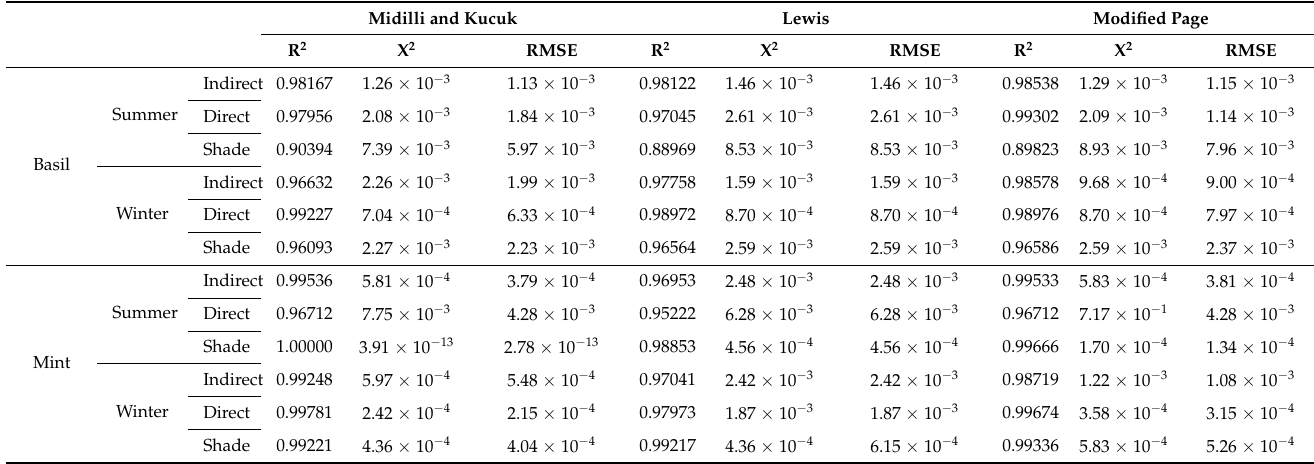
R 2 : Coefficient of determination, X 2 : chi-square, and RMSE: Root Mean Square Error. The moisture ratio curves presented in Figure 5 show that the best-resembled model for Mint herb was Midilli-Kucuk in both seasons (summer, and winter). As shown in Table 2, the best model had higher R 2 = 0.99536, 0.99248; lower X 2 = 5.81 × 10 − 4 , 5.97 × 10 − 4 ; and RMSE = 3.79 × 10 − 4 , 5.48 × 10 − 4 in the summer and winter seasons, respectively. Furthermore, using the other two drying methods sun and shade drying, Mint herbs fitted with Midilli-Kucuk models. In addition, it is clear from Figure 5a that there is a steady decrease in the moisture ratio after 9 h due to the experiment being continued for two days in the wintertime. Figure 5b shows that the summer drying was faster than winter because of the differences in ambient temperature and relative humidity. Summer drying took 1.5 h, and in winter it was 10–14 h to reach the expected moisture content.